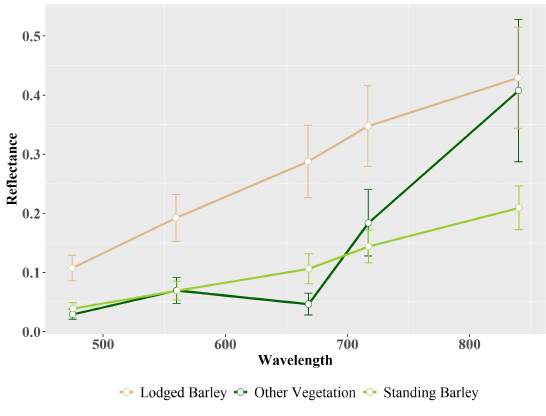
Figure 7. Spectral signatures of the three